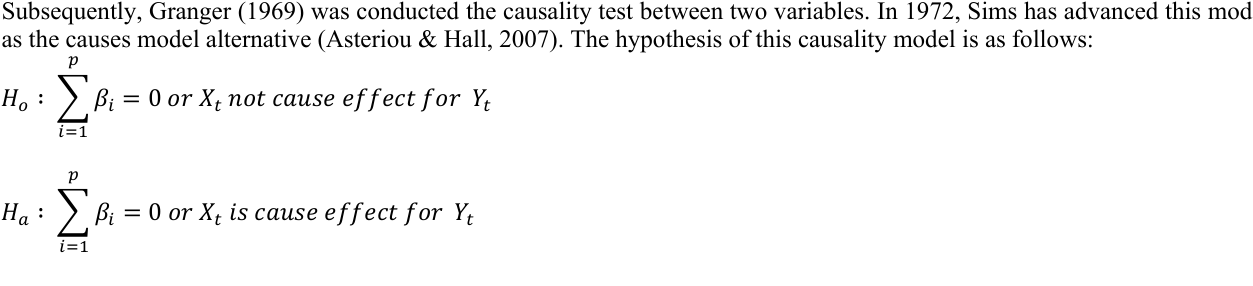
Augmented Dickey Fuller (ADF) test for a unit root